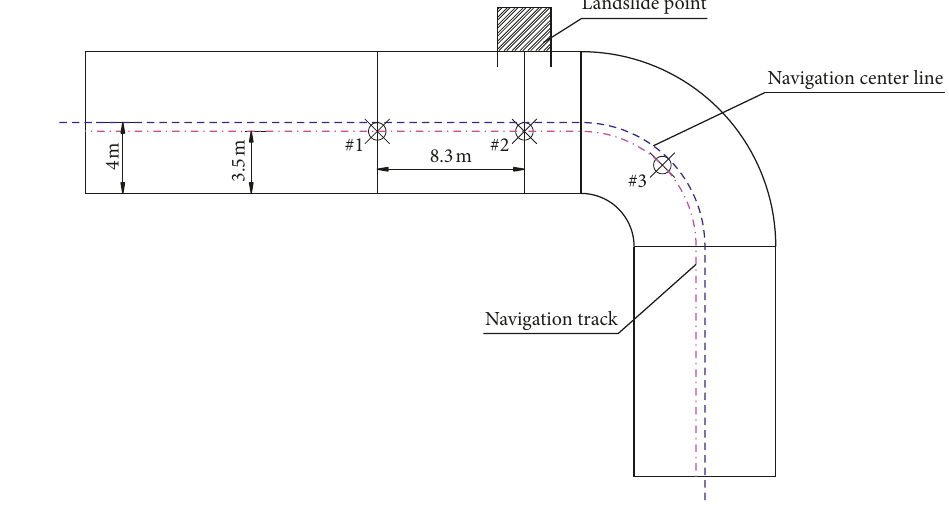
Figure 2: Layout of the river channel model.